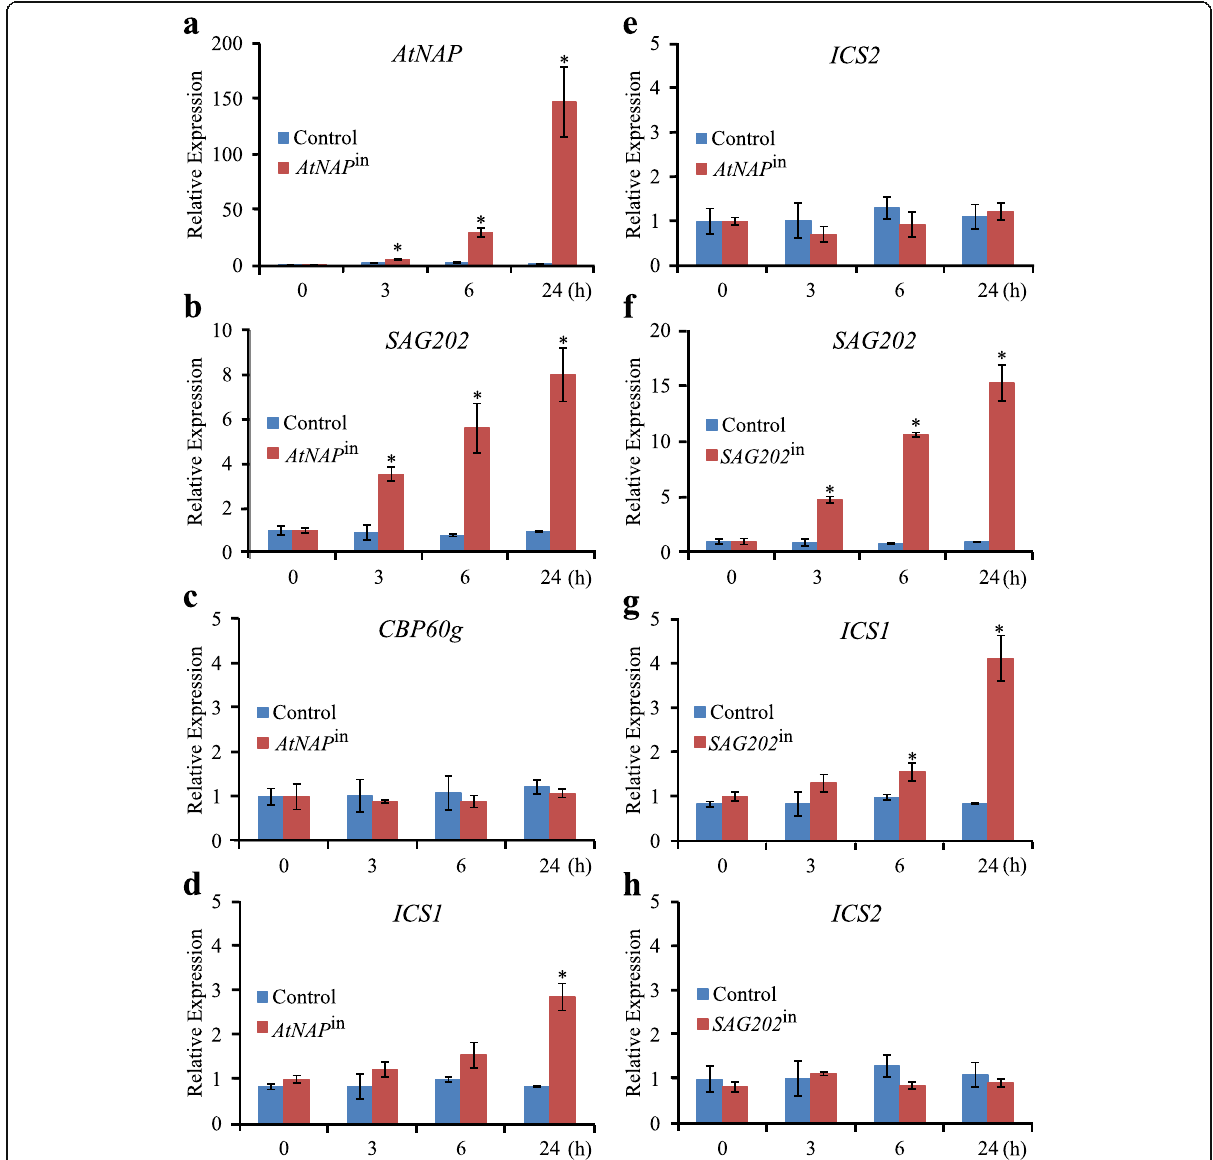
Fig. 2 qPCR analyses of gene expression upon chemical induction of AtNAP or SAG202 . ( a - e ) The transcript levels of AtNAP , SAG202 / SARD1 , CBP60g , ICS1 and ICS2 in the AtNAP inducible ( AtNAP in ) and control lines at 0 h, 3 h, 6 h and 24 h after DEX treatment. ( f - h ) The transcript levels of SAG202 , ICS1 and ICS2 in the SAG202 in and control lines at 0 h, 3 h, 6 h and 24 h after DEX treatment. Relative expression levels were calculated and normalized with respect to Actin 2 ( ACT2 ) transcripts. Error bars indicate SD of three biological repeats. * P < 0.05 using Student ’ s